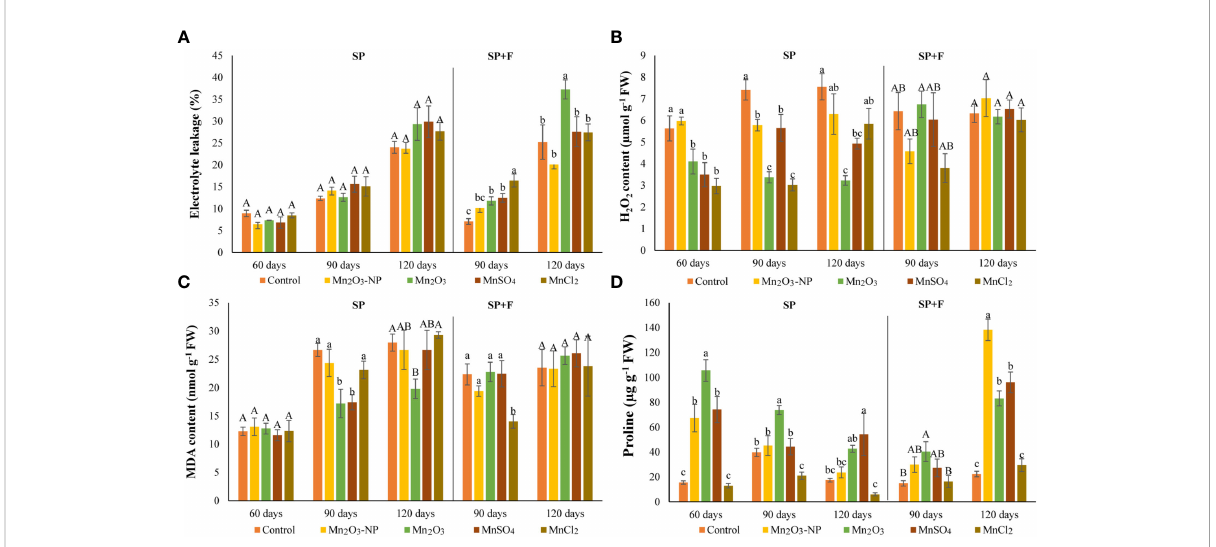
FIGURE 3 Electrolyte leakage (A) , H 2 O 2 (B) , MDA (C) , and proline (D) contents in A. annua primed with different Mn forms at different durations. Data are mean ± SE (n=3). The different letters indicate statistically signi fi cant differences between Mn treatments within the same group at p<0.05. Capital letters represent no signi fi cant differences,